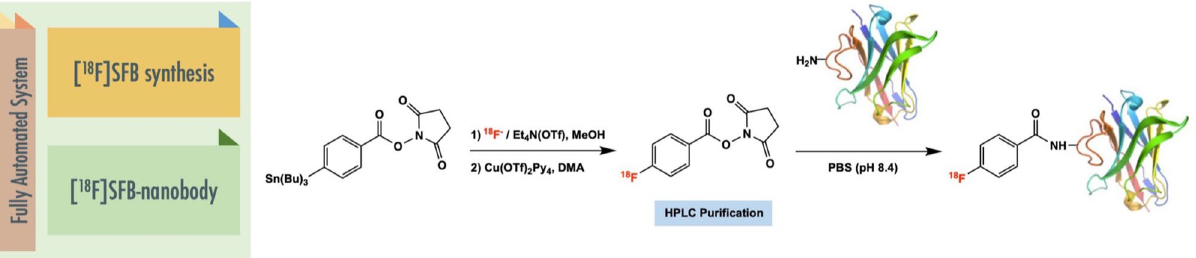
Figure 1. Fully automated system of [ 18 F]SFB-nanobody.